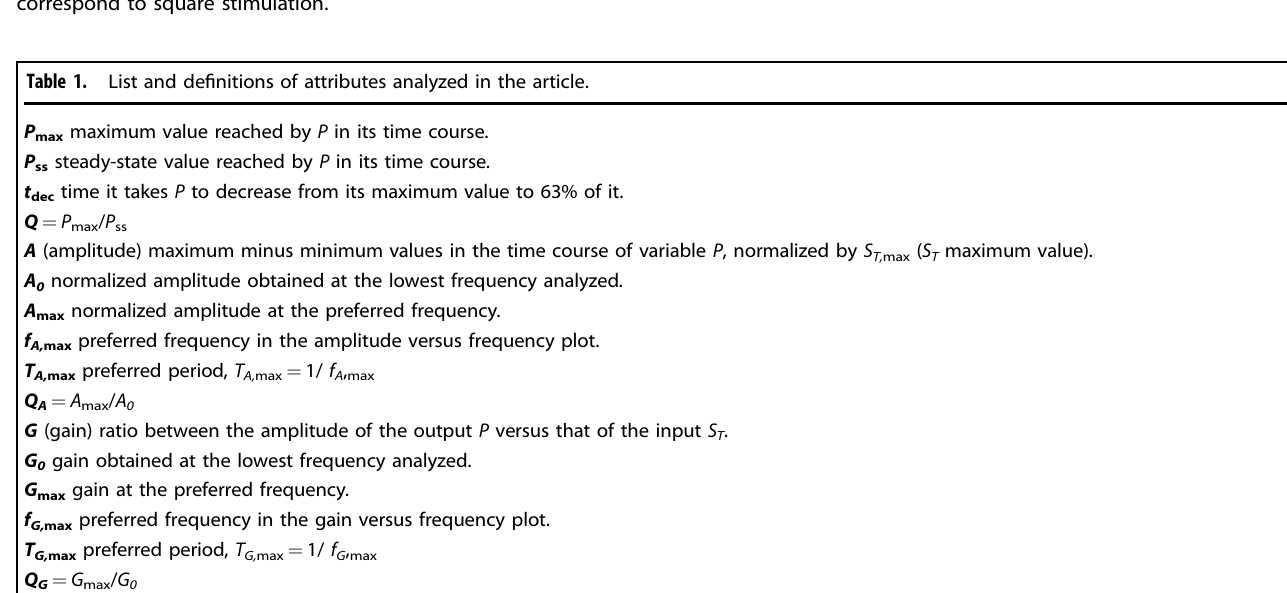
Fig. 6 Parameter space exploration for periodic stimulation. a Schematic representation of the two different scenarios analyzed, constant (left) and periodic (right) stimulation, and the attributes selected in each one. Constant stimulation is a step in S T going from zero to the desired value at t = 0 and periodic stimulations are the adapted variations, sinusoidal, or train of square pulses, indicated in Figs. 4a – c and 4d – e, with frequencies in the range 10 − 4 – 10 1 Hz, resulting in periods in the range 0.1 − 10 4 s. For constant stimulation, the attributes are t dec and P max . For periodic stimulations, the attributes are T A, max , A max , T G ,max , G max (being T the period, T = 1/ f ). The frequency for which the maximum amplitude/gain is obtained and the corresponding maximum amplitude/gain is indicated over the plots as f A, max , f G, max , and A max , G ma x . b Results from the parameter sampling with 5,000 parameter sets. Sinusoidal stimulation was applied as S T ( t ) = S max (1 + 0.5sin(2 π ft ))/1.5, then adapted as explained in Fig. 4 (and the text). Train of square pulses stimulation was applied as S T = S max for nT < t <( n + 0.5) T , S T = 0 for ( n + 0.5) T < t <( n + 1) T , n is a natural number, implying the input in the fi rst half of the period. From the 5,000 parameter set values analyzed, 149 resulted in signal termination and all of them exhibited a maximum in the gain versus frequency plot, and also in the amplitude versus frequency plot but for sinusoidal stimulation only. Scatter plots relating an attribute from the output to periodic stimulation and an attribute from the output to step stimulation. The Pearson coef fi cient for each case is indicated over the plot. Left plots are T G ,max and T A, max versus t dec , right plots are G max and A max versus P max . Scatter plots in dark yellow correspond to sinusoidal stimulation and scatter plots in cyan correspond to square stimulation.